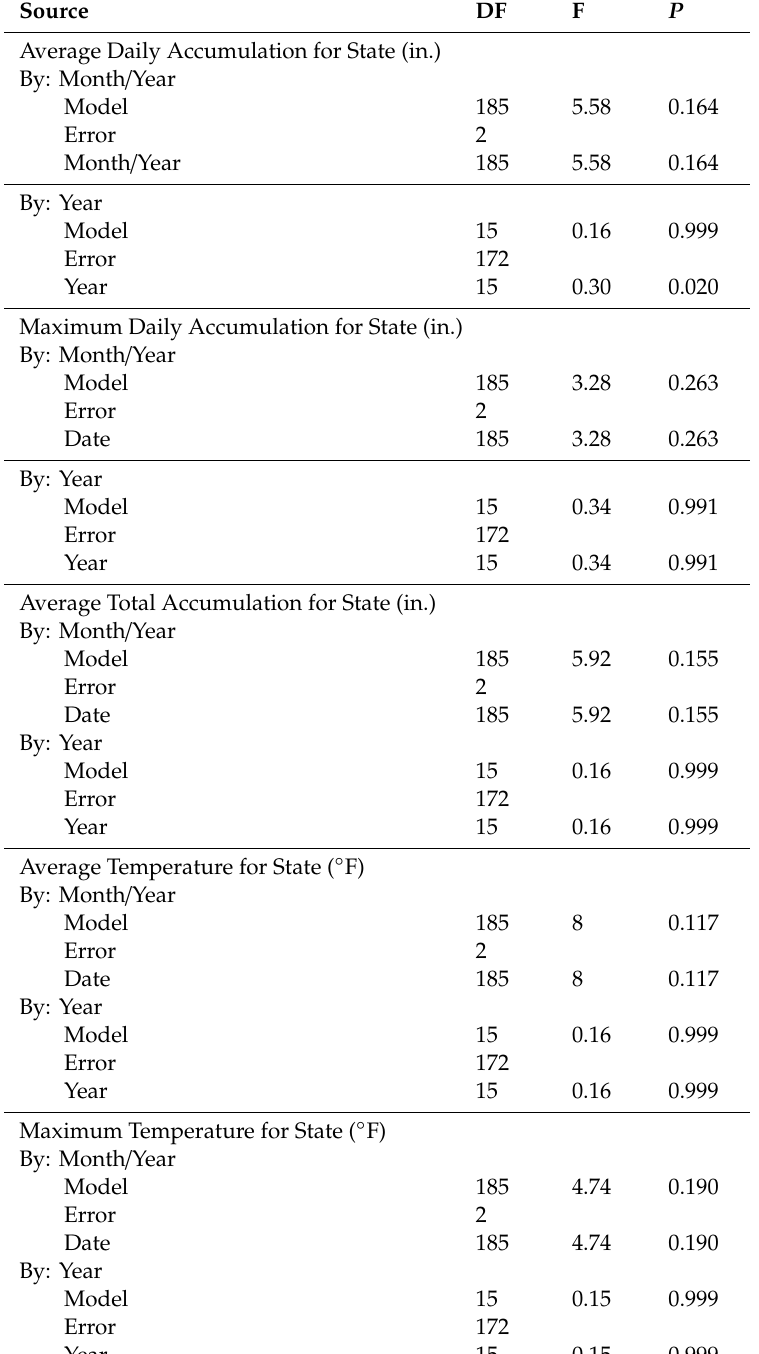
Table A2. Environmental parameters statewide for years 2001–2016, displaying tests for statistical di ff erences for each respective parameter and year